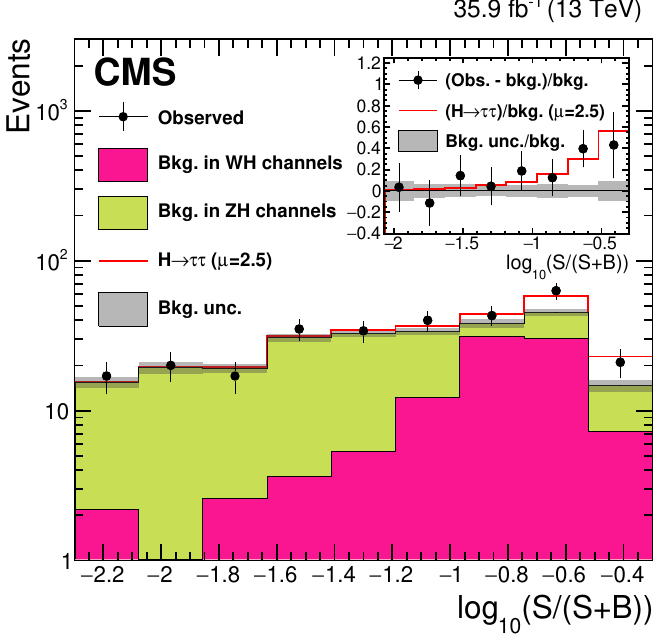
Figure 5 . Distribution of the decimal logarithm of the ratio between the expected signal and the sum of the expected signal and background. The signal, corresponding to the best (cid:12)t value (cid:22) = 2 : 5, and expected background in each bin of the mass distributions used to extract the results, in all (cid:12)nal states are combined. The background contributions are separated based on the analysis channel, WH or ZH. The inset shows the corresponding di(cid:11)erence between the data and expected background distributions divided by the background expectation, as well as the signal expectation divided by the background